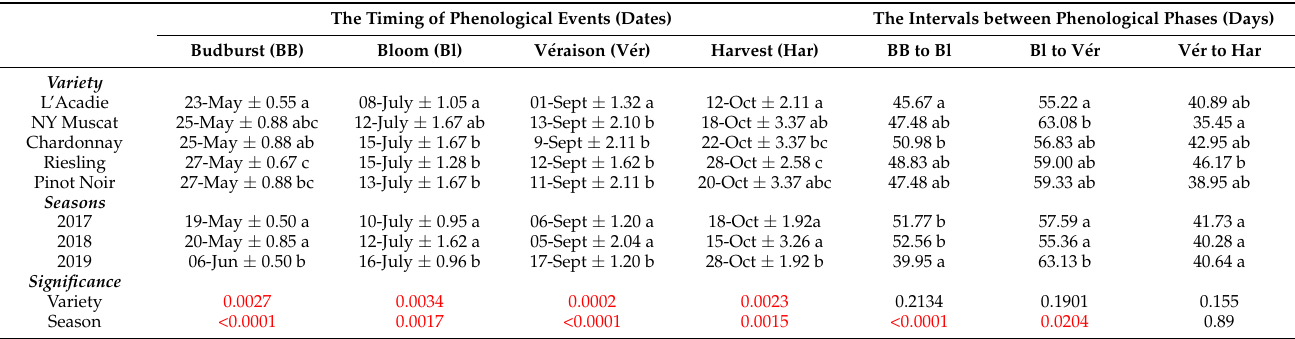
Table 3. The average occurrence of phenological stages, expressed in dates, and the length between phenological phases (expressed in days) in cold-hardy interspecific hybrid grapes and Vitis vinifera varieties from 2017 to 2019. The Timing of Phenological Events